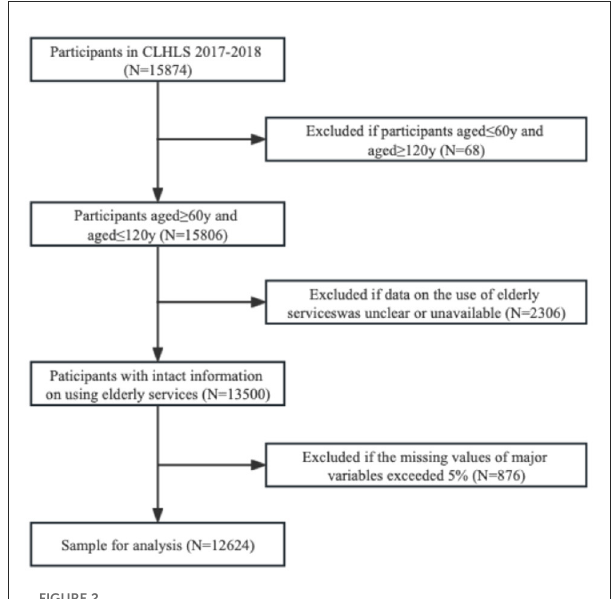
FIGURE2 Flowchart of the study sample